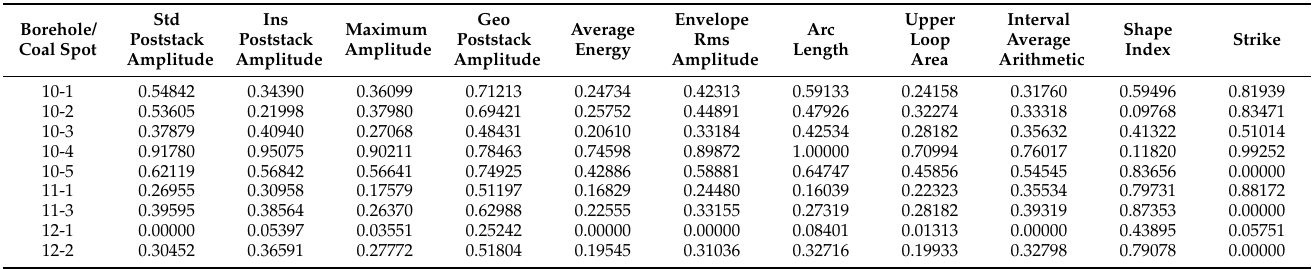
Table A3. Preliminary seismic attribute data corresponding to geological boreholes in the develop- ment stage (after